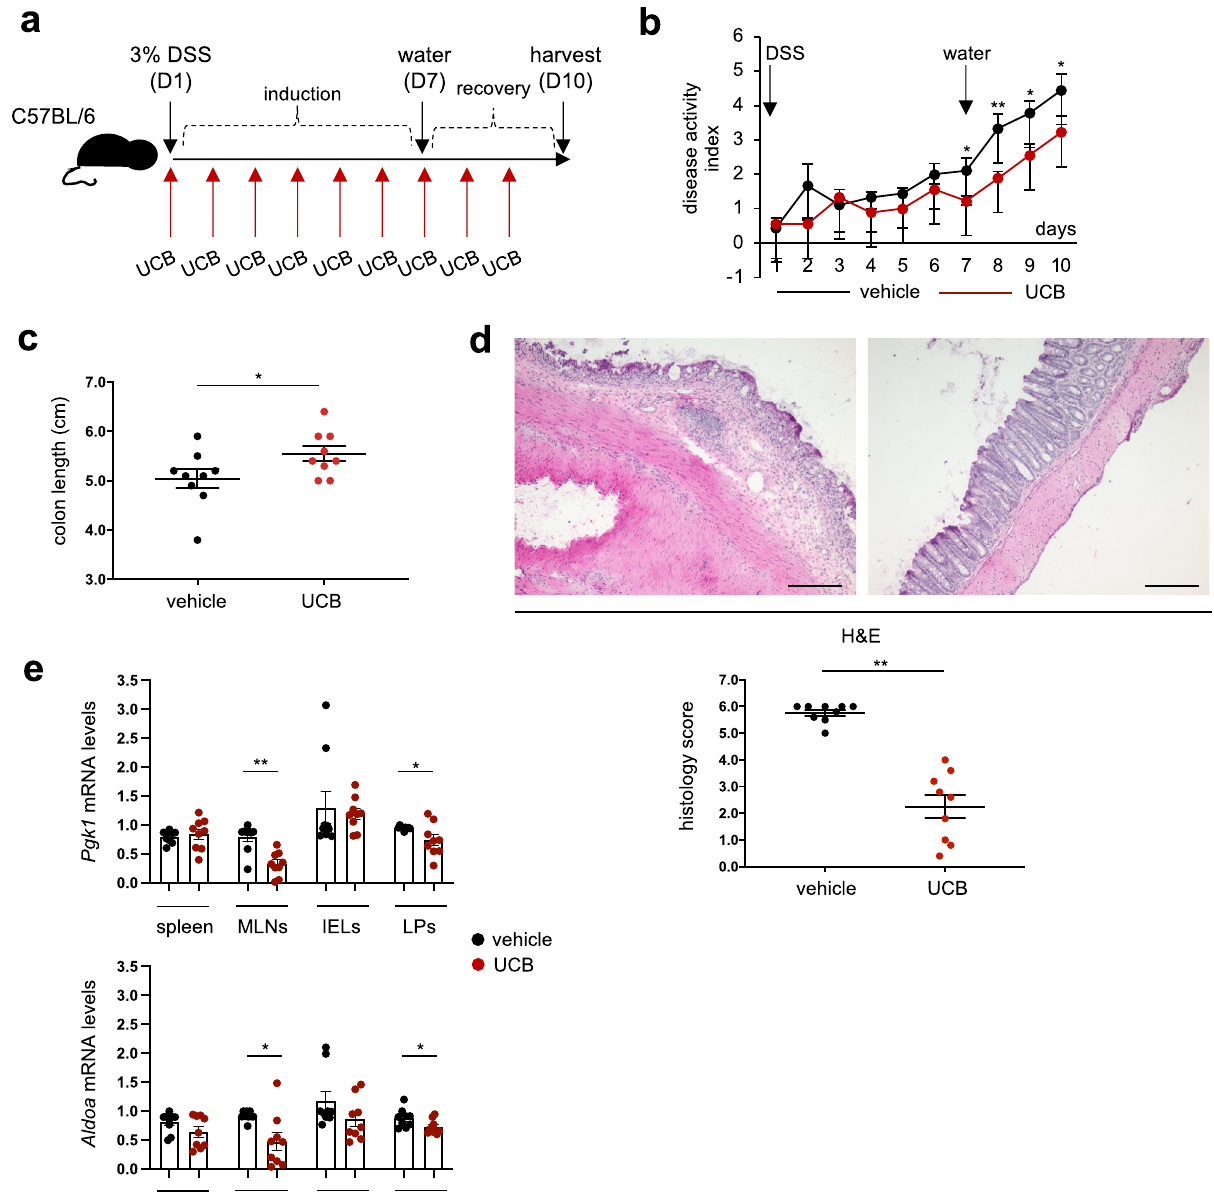
Fig. 4 UCB decreases Pgk1 and Aldoa levels in CD4 cells of mice with DSS colitis. a Wild-type mice were exposed to 3% dextran sulfate sodium (DSS) for 6 days. DSS was then replaced with normal drinking water for an additional 4 days. For the whole experiment duration, mice were administered either vehicle ( n = 9) or unconjugated bilirubin (UCB) ( n = 9) at 20 μ mol/kg/day. b Mean ± SEM disease activity index in vehicle and UCB treated animals. c Mean ± SEM colon length (cm) at the time of harvesting. d Hematoxylin and Eosin (H&E) staining of colon sections from untreated and UCB treated mice (original magni fi cation, ×10, scale bar: 200 μ M); mean ± SEM histology score at the harvest is also shown. Mean ± SEM ( e ) Pgk1 and Aldoa mRNA levels in CD4 lymphocytes isolated from the spleen, mesenteric lymph node (MLN), intra-epithelial (IEL), and lamina propria (LP). * P ≤ 0.05 and ** P ≤ 0.01, using two-sided unpaired t